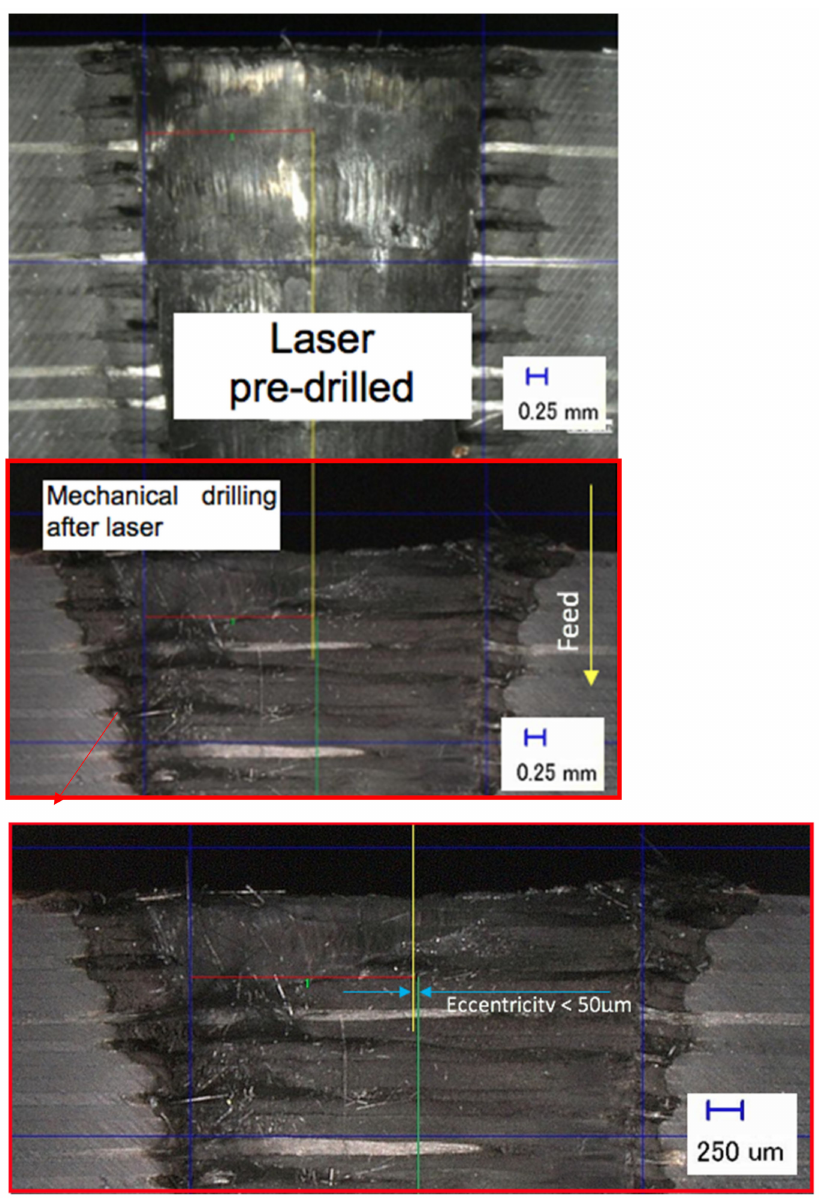
Figure 4. Example of sequential drilling alignment accuracy